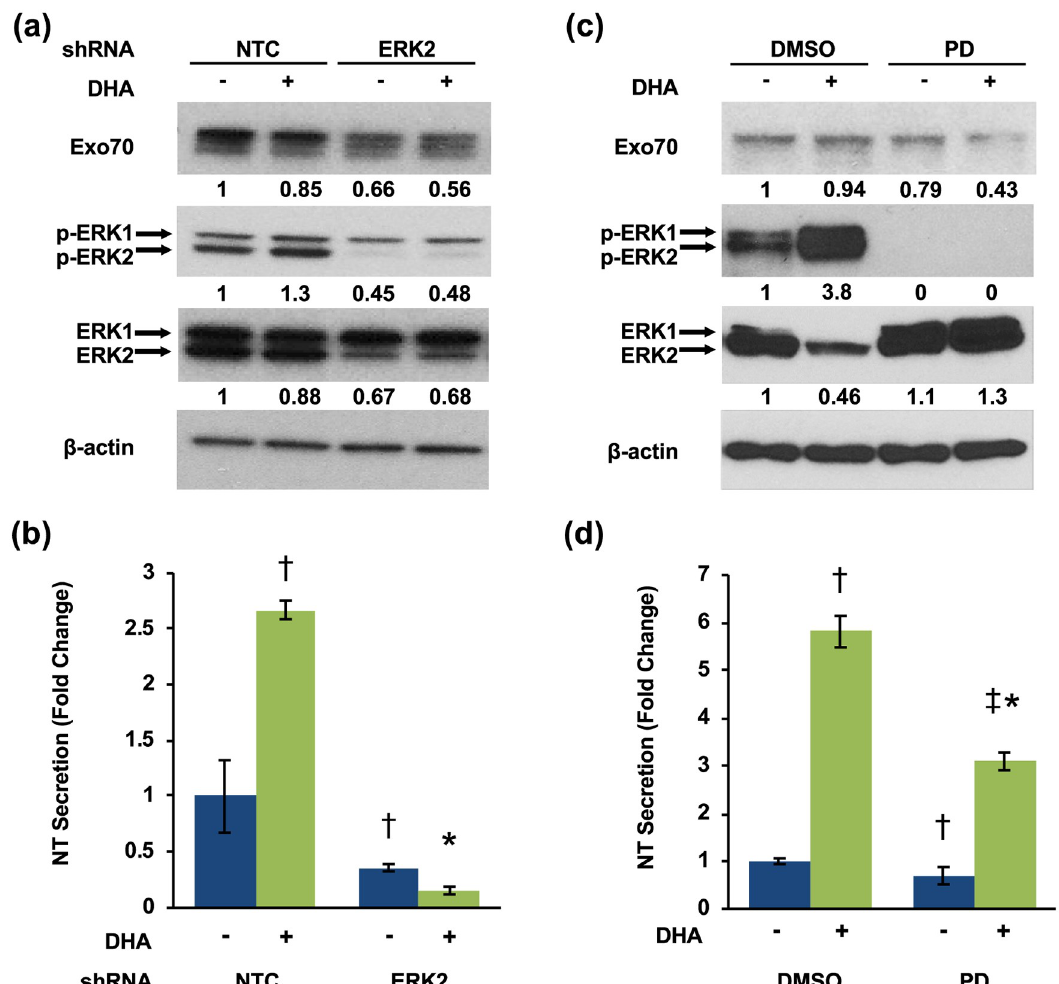
Fig 5. ERK1/2 inhibition attenuates Exo70 expression. (a) BON cells stably expressing NTC or ERK2 shRNAs were treated with or without 30 μ M DHA for 90 min. Cells were lysed and western blotting analysis performed. Band intensity is indicated below the corresponding band and expressed as fold-change relative to NTC. (b) Media were collected and NT-EIA performed (†p < 0.05 vs. untreated NTC; � p < 0.05 vs. NTC plus DHA; data represent mean +/- SD). (c) BON cells pre-treated with DMSO or PD 0325901 for 30 minutes were treated with or without 100 μ M DHA for 90 min. Cells were lysed and western blotting analysis performed. Band intensity is indicated below the corresponding band and expressed as fold-change relative to NTC. (d) Media were collected and NT-EIA performed (†p < 0.05 vs. DMSO without DHA; � p < 0.05 vs. DMSO plus DHA; ‡p < 0.05 vs. PD without DHA; data represent mean +/- SD). All data are representative of three independent